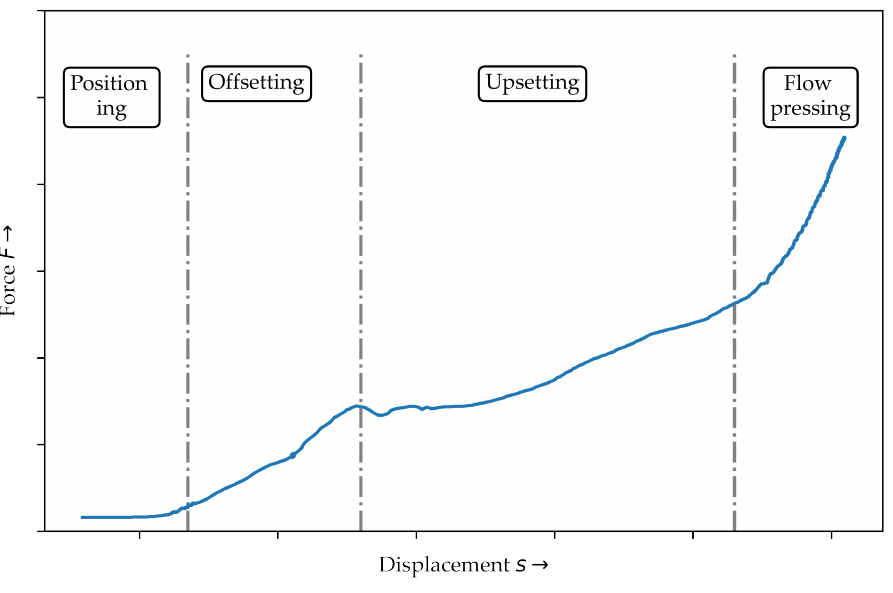
Figure 1. Measured force-displacement curve of the hotclinching process and the four phases of clinching based on